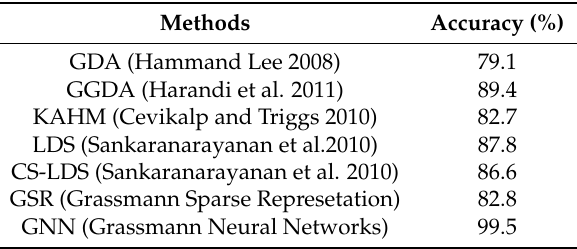
Table 2. Results of the experiment.